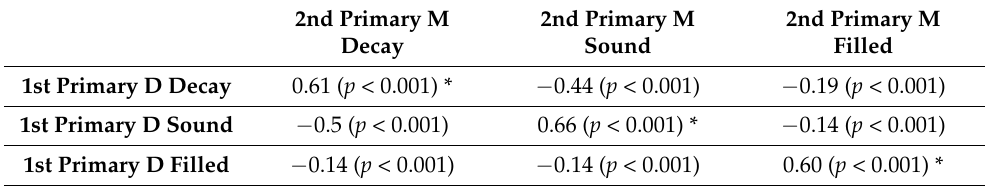
Figure 2. Mean ± SD of the decayed, sound, and filled distal surfaces of the first primary molars, and the mesial surfaces of the second primary molars ( n = 1194). Table 2. Pearson correlations between adjacent decayed, sound, and filled 1st and 2nd primary molars in the study sample ( n =